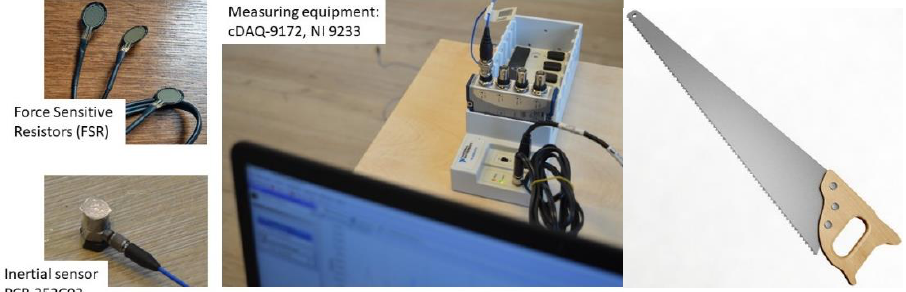
Figure 2. The measuring equipment for the shear force and vibration (acquisition board, force, and inertial sensors) and the hand saw.